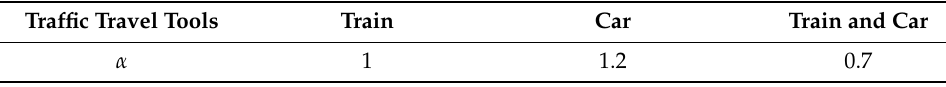
Table 2. The commute distance correction weight α .